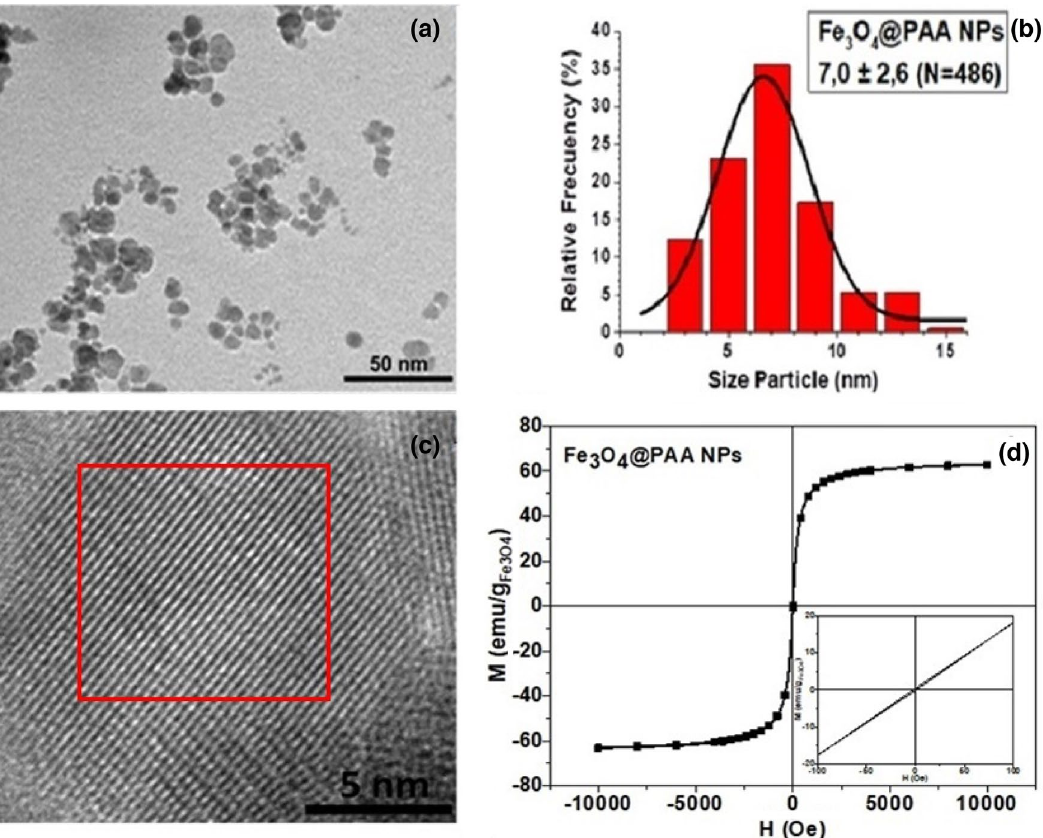
Figure 1. Fe3O4@PAA nanoparticle characterizations: ( a) TEM image. ( b) Statistical distribution of magnetic core diameters. ( c) HRTEM image, where the red square denotes the area of highest crystalline quality. ( d) Hysteresis loop at room temperature.